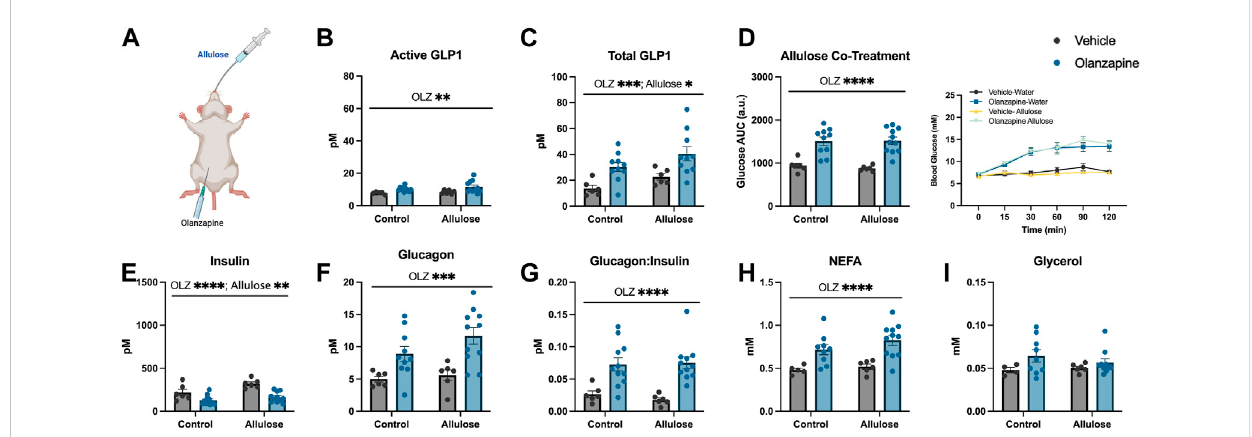
FIGURE 1 Allulose cotreatment does not protect against olanzapine-induced changes in glucose homeostasis. Mice were co-treated with an IP injection of olanzapine (5 mg/kg) and allulose gavage (1 g/kg) (A) for 120 min ( n = 6 – 11 mice/group). (B, C) Active and total GLP1 were measured from serum following 120 min from injection. (D) Blood glucose was measured from the distal tail blood and area under the curve (AUC) calculated. In serum collected from cardiac blood, insulin (E) , glucagon (F) , the ratio of glucagon:insulin (G) , Non-Esteri fi ed Fatty Acids (H) , and glycerol (I) were measured. Blood glucose AUC and serum hormones/metabolites were analyzed by two-way ANOVA. Lines over graphs indicate a main effect of the described parameter. * p < 0.05, ** p < 0.01, *** p < 0.001, **** p < 0.0001 between indicated groups. All data are presented as mean ±